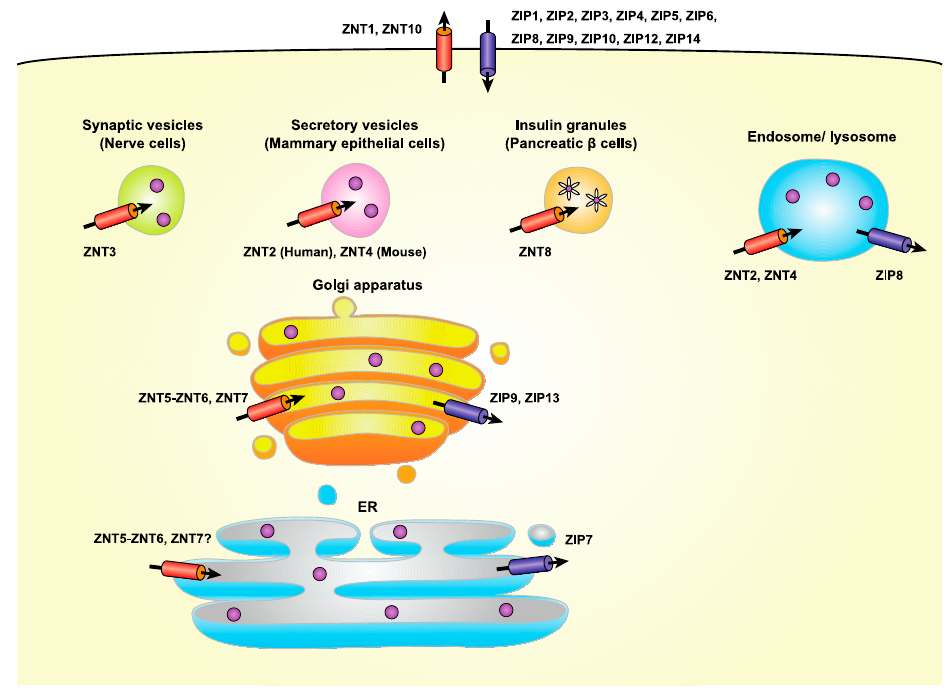
Figure 1. Subcellular localization of ZNT and ZIP transporters. ZNT transporters move cytosolic zinc into the lumen of vesicles involved in the early secretory pathway, including the endoplasmic reticulum (ER), Golgi apparatus, as well as into cytoplasmic vesicles/granules such as synaptic and secretory vesicles and insulin granules, in which specific ZNT proteins are localized. ZNT5 and ZNT6 form heterodimers to transport zinc. ZIP transporters move zinc in the opposite direction. In contrast to the specific localization of ZIP9, ZIP13, and ZIP7 in the Golgi apparatus and the ER, the subcellular location of ZNT5-ZNT6 heterodimers has not been definitively determined.